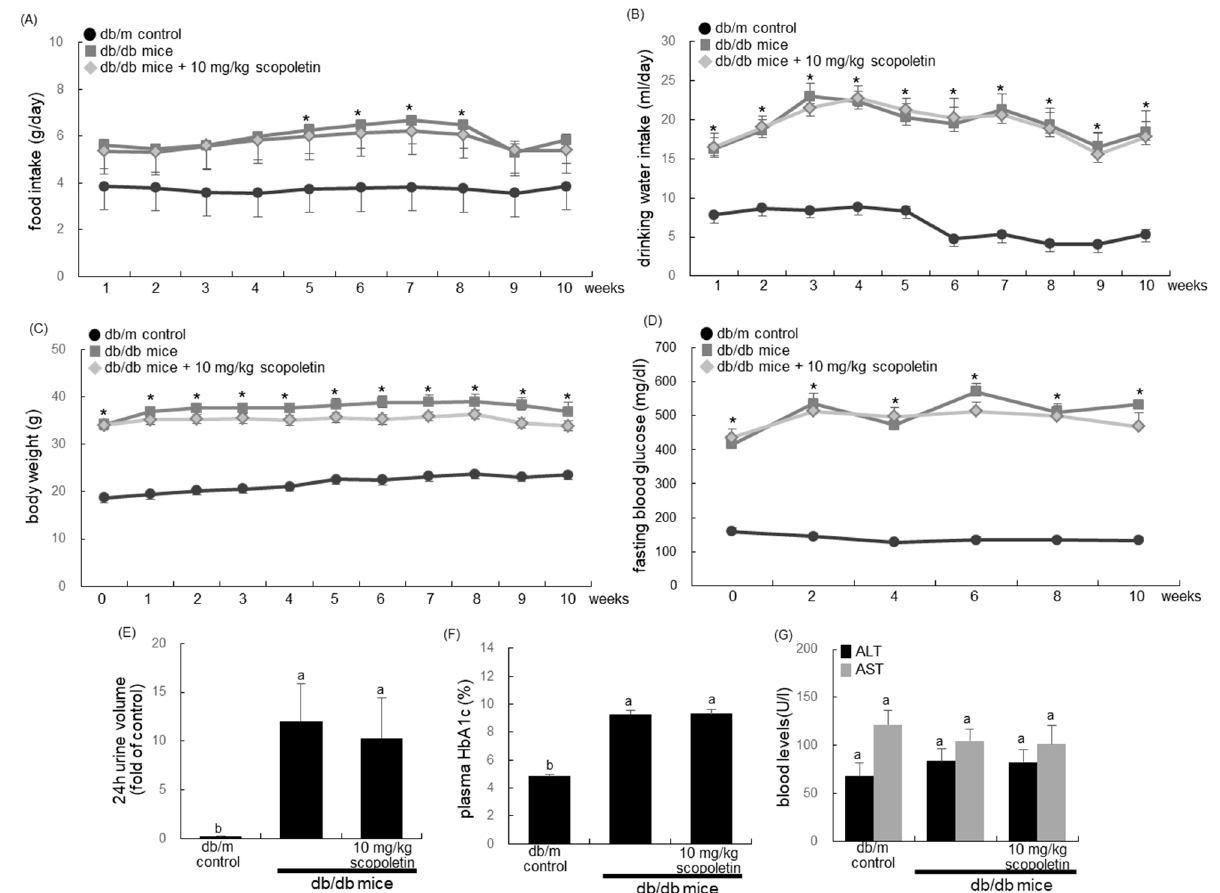
Figure 3. Food and drinking water intake ( A , B ), body weight ( C ), and fasting blood glucose level ( D ) of db/m control and db/db mice. The db/db mice were orally administrated with 10 mg/kg scopoletin daily for 10 weeks. The food intake, drinking water intake, and body weight were measured during the 10-week scopoletin supplementation, and expressed as mean ± SEM ( n = 7). * p < 0.05 for db/m controls. In addition, 24-h urine volume ( E ), plasma glycated hemoglobin level (HbA1c, F ), and plasma levels of aspartate transaminase (AST) and alanine transaminase (ALT) ( G ) were measured after the 10-week scopoletin supplementation. The values shown in bar graphs (mean ± SEM, n = 7) not sharing a common small letter are significantly different, at p <